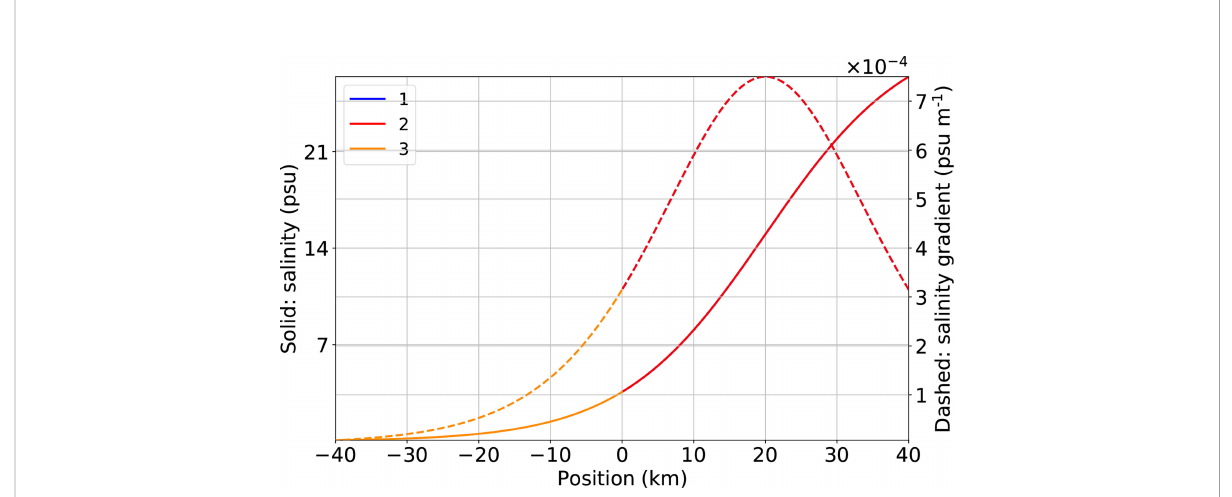
FIGURE 4 The salinity (solid line) and its gradient magnitude (dashed line) for all experiments.